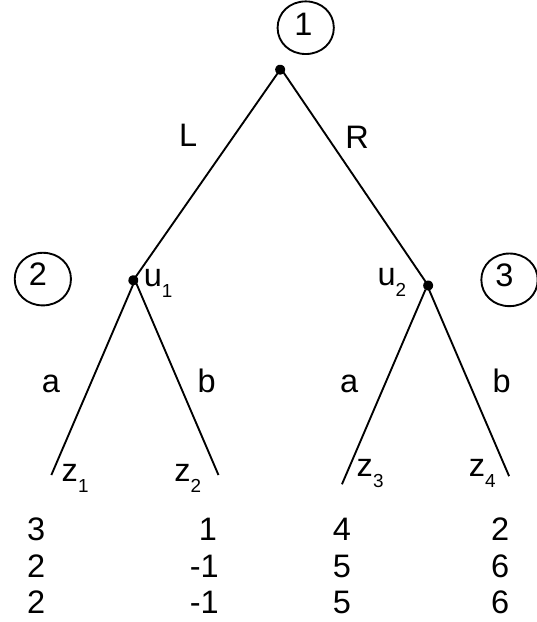
Figure 2. Three-player game with incredible